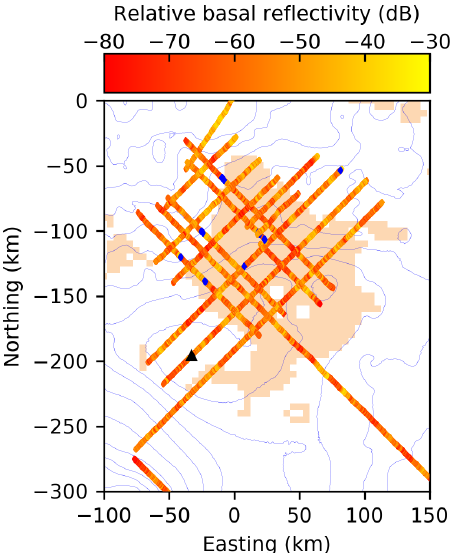
Figure 5. Observed relative basal reflectivity. Reflectivity is cor- rected for geometric spreading and englacial dielectric attenuation. Locations of reflectivity that exceed − 30dB are plotted in blue. The candidate A ice core target region is in orange (Van Liefferinge and Pattyn, 2013). The dome summit location is plotted as a black tri- angle. The 500Pa contour intervals are hydraulic potential using Bedmap2 (Fretwell et al., 2013) and zero effective pressure. The highest contour surrounding the dome summit is 29kPa. The coor- dinate system used is polar stereographic (EPSG:3031).